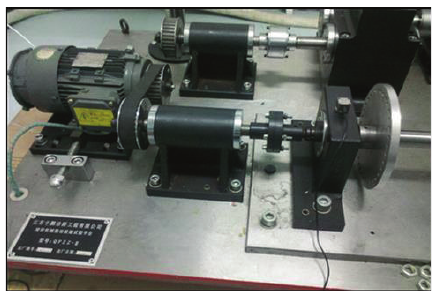
Figure 11: Rolling bearing test stand.